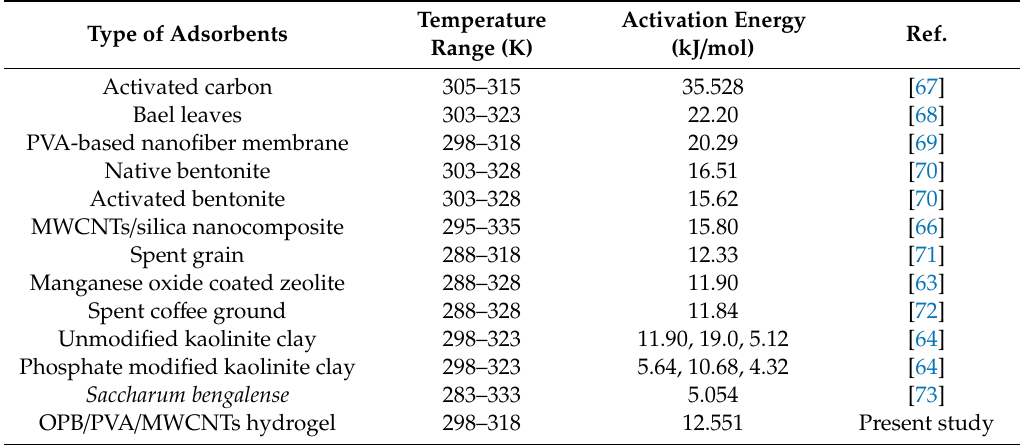
Table 6. Activation energies obtained for the adsorption of Pb(II) using di ff erent type of adsorbents.